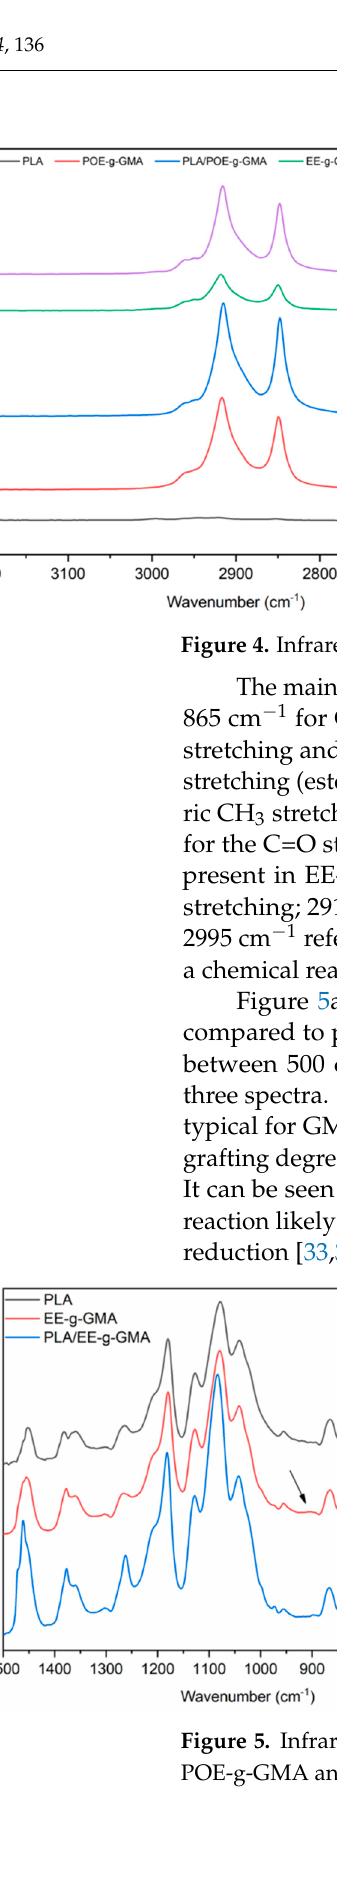
Figure 5. Infrared spectra of pure PLA, ( a ) EE-g-GMA and of the blend PLA/EE-g-GMA and ( b ) POE-g-GMA and of the blend PLA/POE-g-GMA.